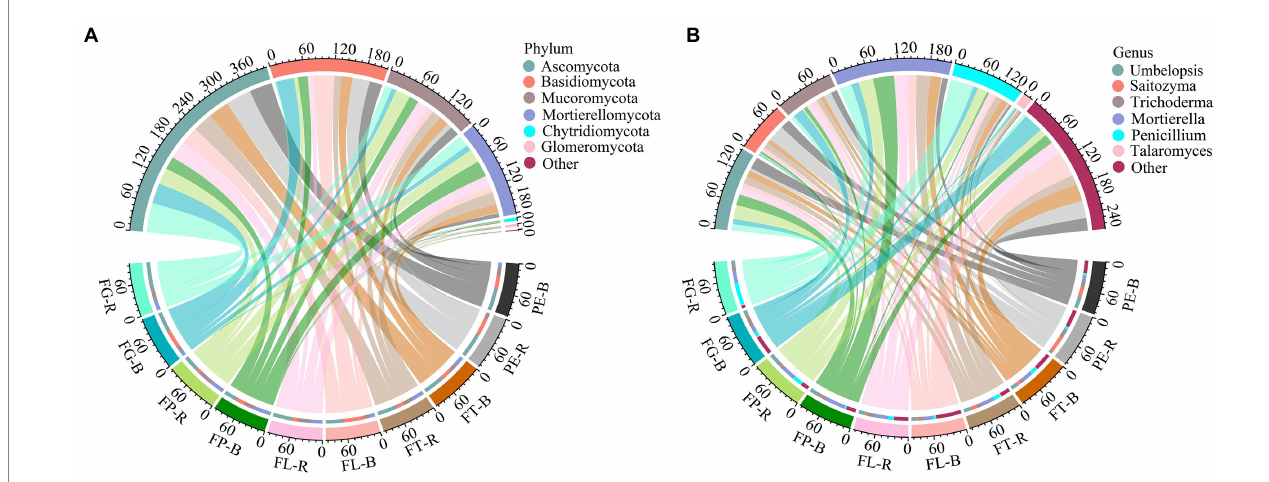
FIGURE 2 Composition of major fungal taxa at the phylum (A) and genus (B) level. Rhizosphere soil (R): PE-R, Phyllostachys edulis ; FT-R, P. edulis f. tao kiang ; FL-R, P. edulis f. luteosulcata ; FP-R, P. edulis f. pachyloen; FG-R, P. edulis f. gracilis ; Bulk soil (B): PE-B, P. edulis ; FT-B, P. edulis f. tao kiang; FL-B, P. edulis f.